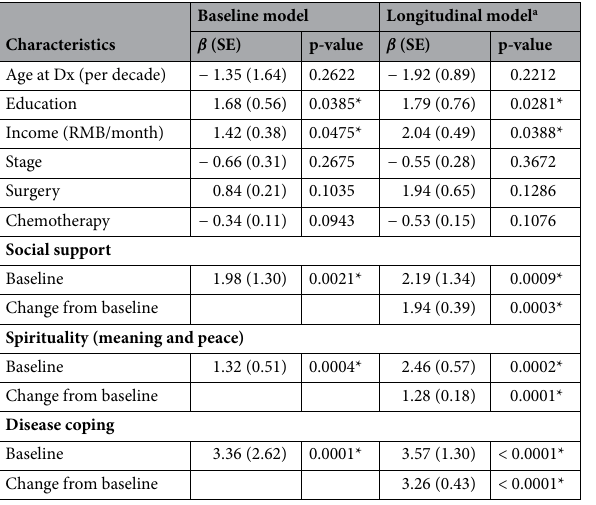
Table 2. Association of demographic, clinical, and psychosocial characteristics with Benefit Finding scores. Demographic and medical variables that were nonsignificant in the models (marital status, employment status and radiation therapy) are not shown. a Longitudinal model using baseline value and change from baseline for time varying covariates. * p ≤ 0.05.